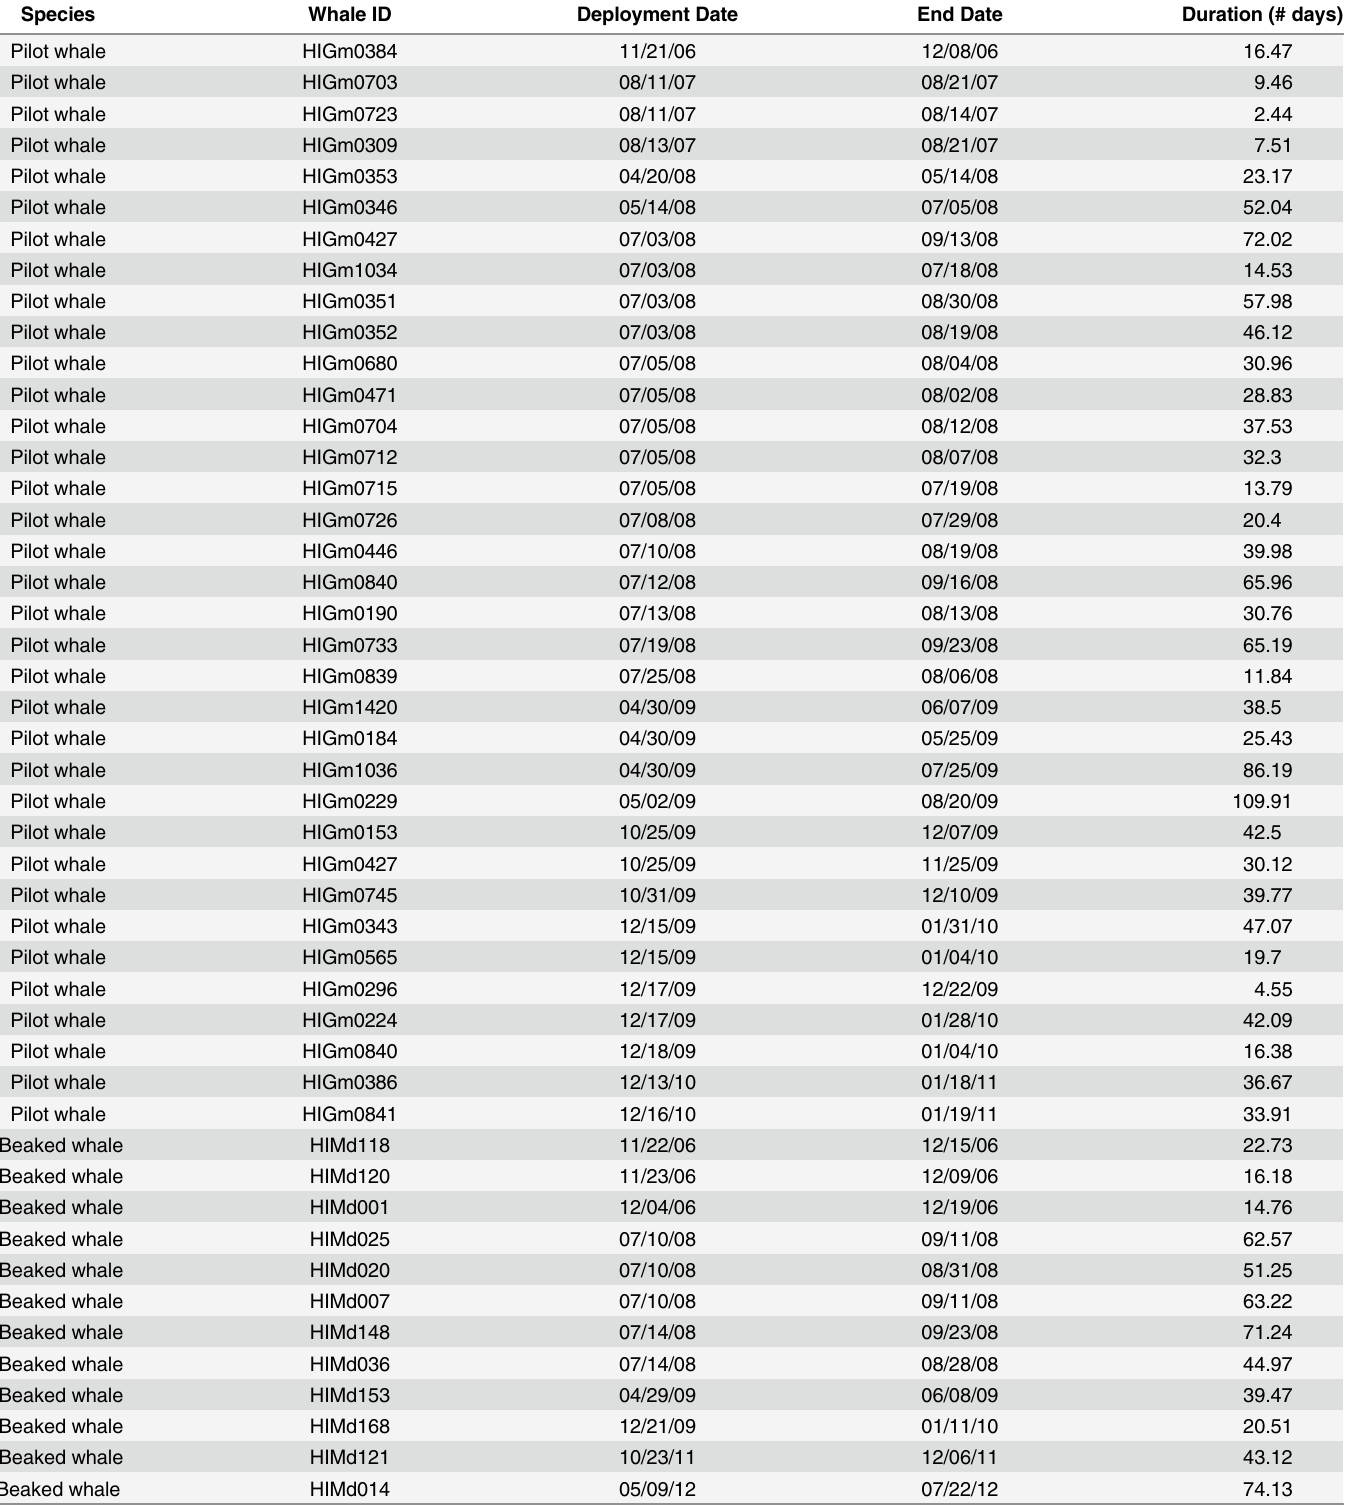
Table 1. Summary of animals satellite